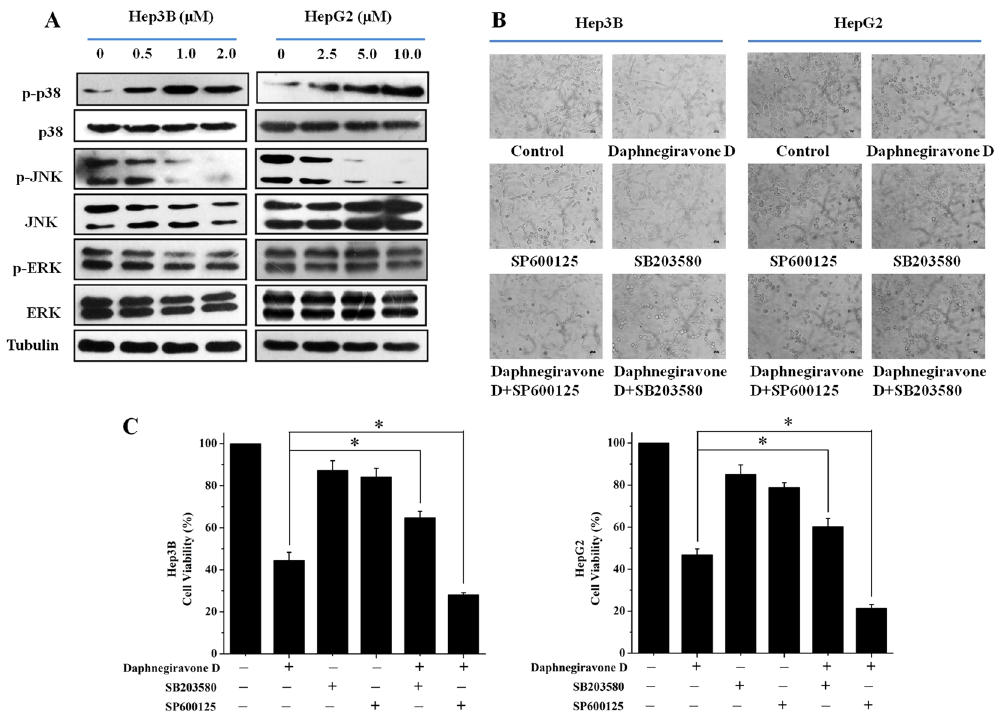
Figure 5. The effects of daphnegiravone D on MAPK pathway. ( A ) The effects of daphnegiravone D on the expressions of MAPK family proteins were detected using Western blot in Hep3B and HepG2 cells. Tubulin was used as a loading control. ( B ) Morphological changes were observed after Hep3B and HepG2 cells were treated with SB203580 (10 μ M), SP600125 (10 μ M) or daphnegiravone D (2 μ M for Hep3B cells and 10 μ M for HepG2 cells) for 48 h (200 × ). ( C ) Cell viability was detected by MTT method after treatment. The statistical data were expressed as mean ± SD for three independent experiments. * p < 0.05 compared with control